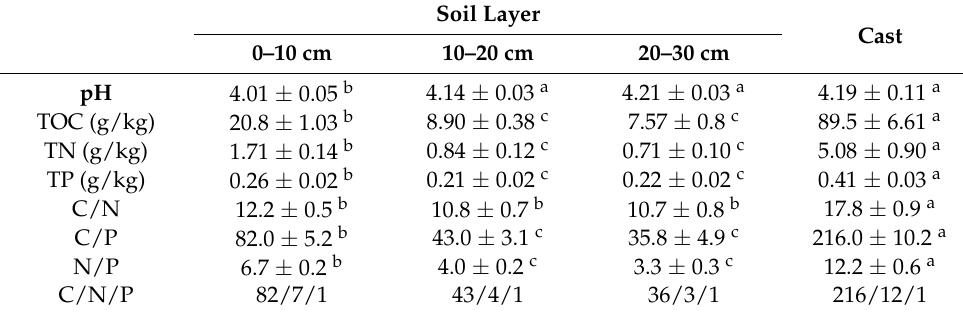
Table 1. Chemical properties of bulk soils and surface earthworm casts (means ± SE, n = 5), including pH, total organic carbon (TOC), total nitrogen (TN) and total phosphorus (TP). Samples were collected in May 2016. Different letters represent significant differences between the three layers of soil and casts (LSD test, P < 0.05).